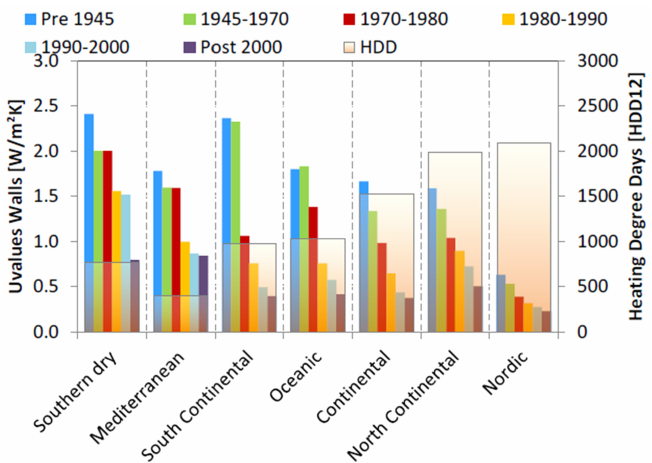
Figure 5. U ‐ values of external walls of the building stock before renovation in different European climate areas with respect to HDD. Source: EU FP7 ‐ iNSPiRe project. D6.5 ‐ Position Paper on Systemic Energy Renovation [22].